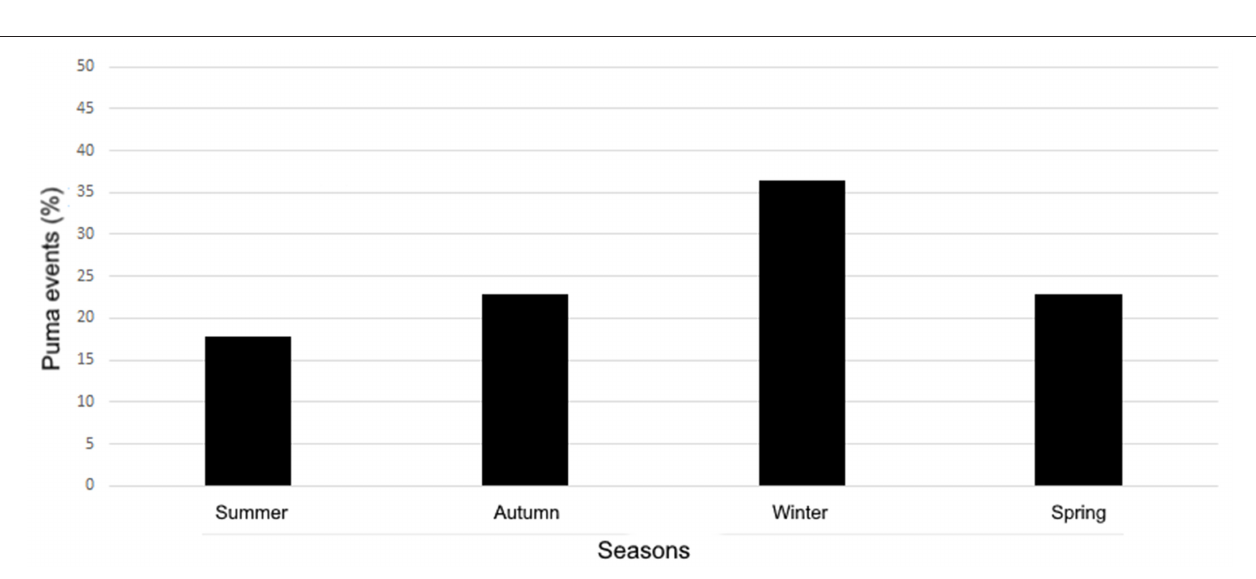
= 10.86, p < 0.05; Figure 3